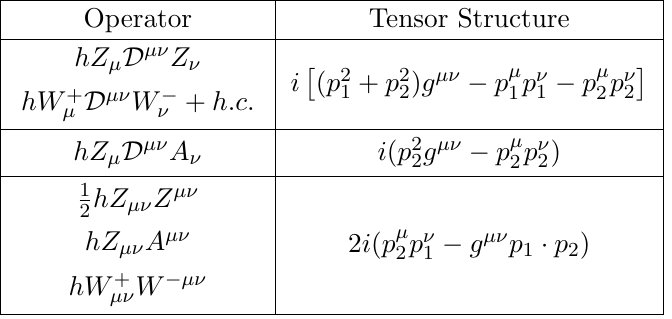
Table 4. The tensor structure of h ( p 3 ) V 1 ( p 1 ; (cid:22) ) V 2 ( p 2 ; (cid:23) ) operators. All the momenta are taken to be